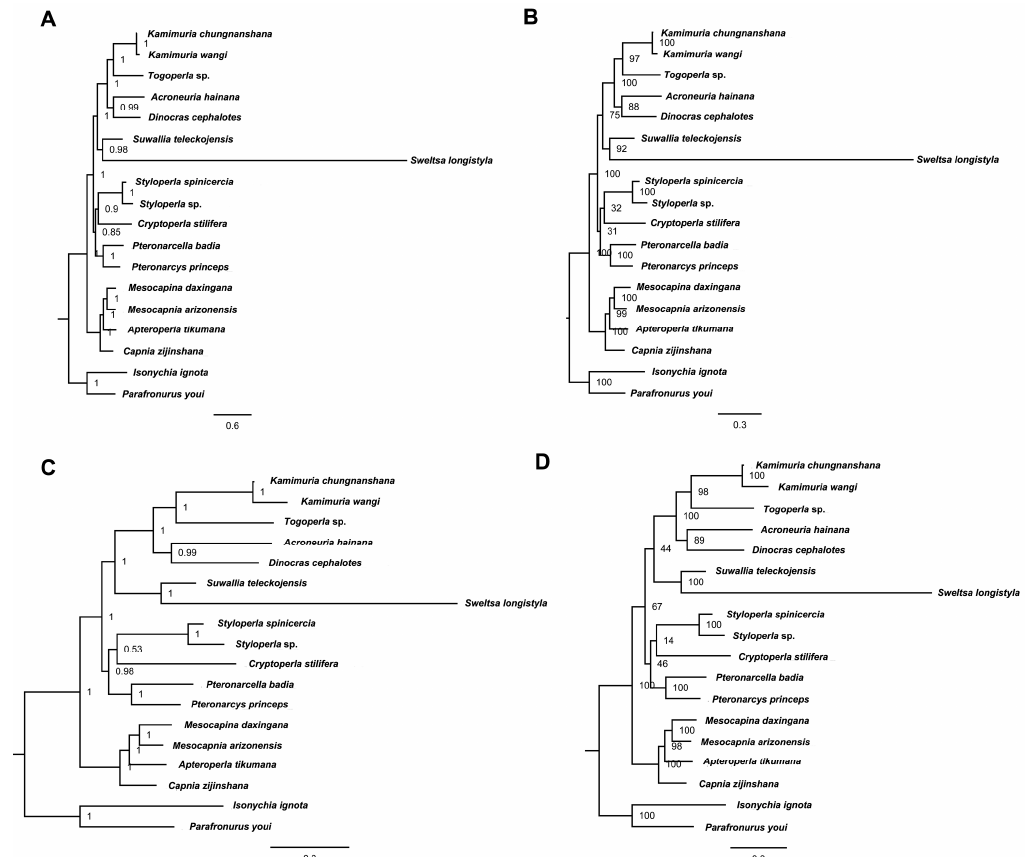
Figure A1. Phylogenetic trees generated from different datasets and methods. ( A ) The tree was obtained by BI analysis of the PCG13 dataset. ( B ) The tree was obtained by ML analysis of the PCG13 dataset. ( C ) The tree was obtained by BI analysis of the PCGR dataset. ( D ) The tree was obtained by ML analysis of the PCGR dataset.